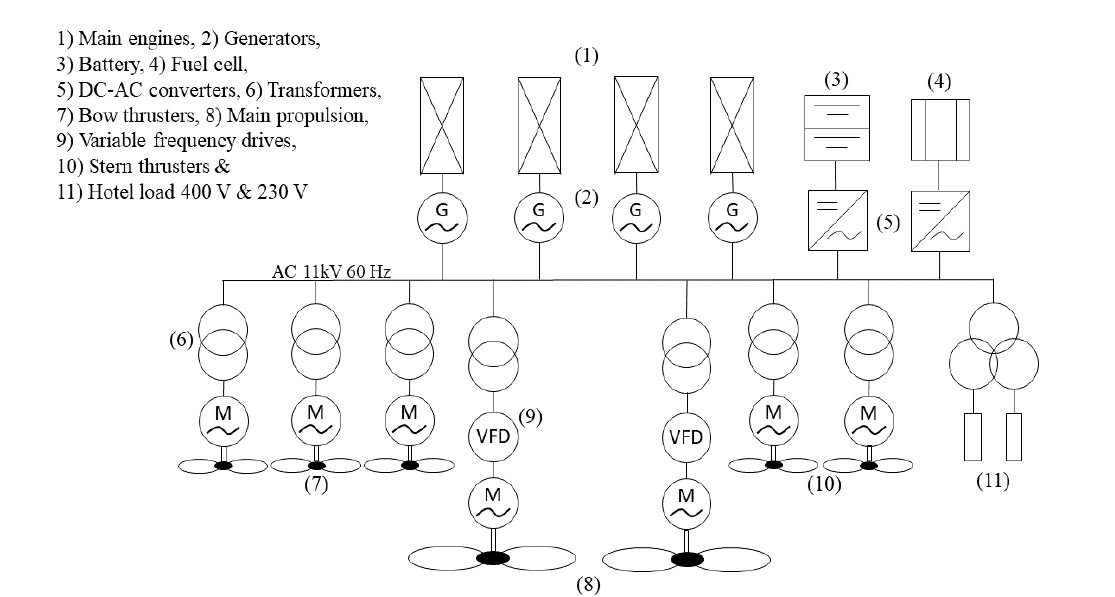
Figure 1. Simplified line diagram of the case study ship including battery and fuel cell systems modelled in this